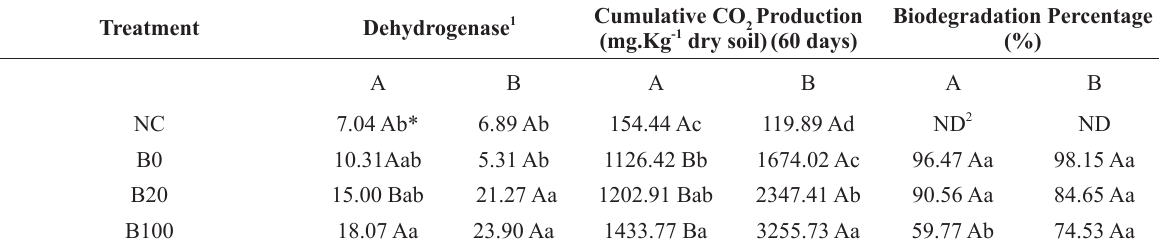
*Averages followed by the same upper case in the lines, and lower case in the columns, do not present statistic difference from each other, according to Tukey test with 5% probability; 1 average of the 6 monitoring points during the 60 days of incubation; 2 TPH values not detected in the soil